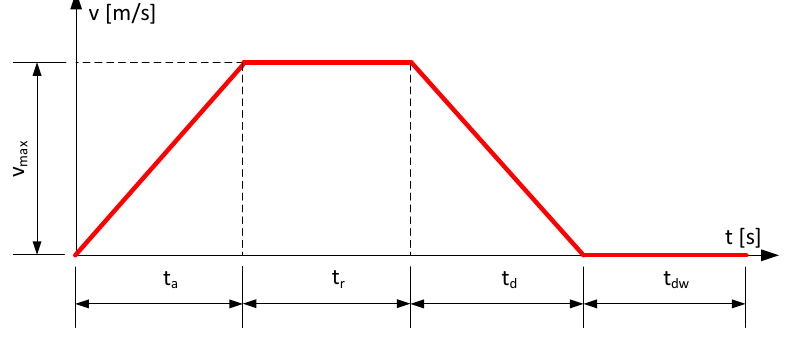
Figure 7. A trapezoidal velocity profile.